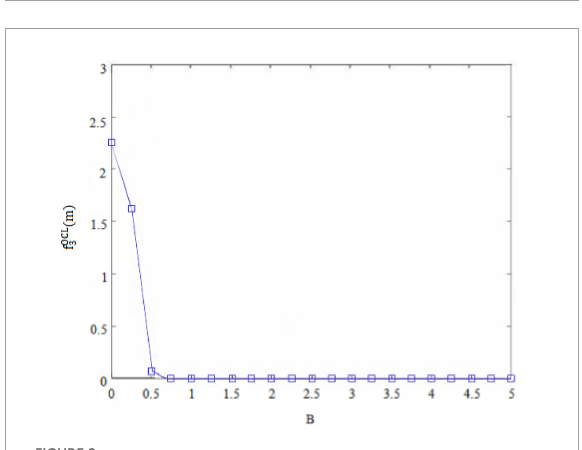
FIGURE8 Deviant innovative behaviors and perceived benefits of “outsiders’ subordinates” with low internal control